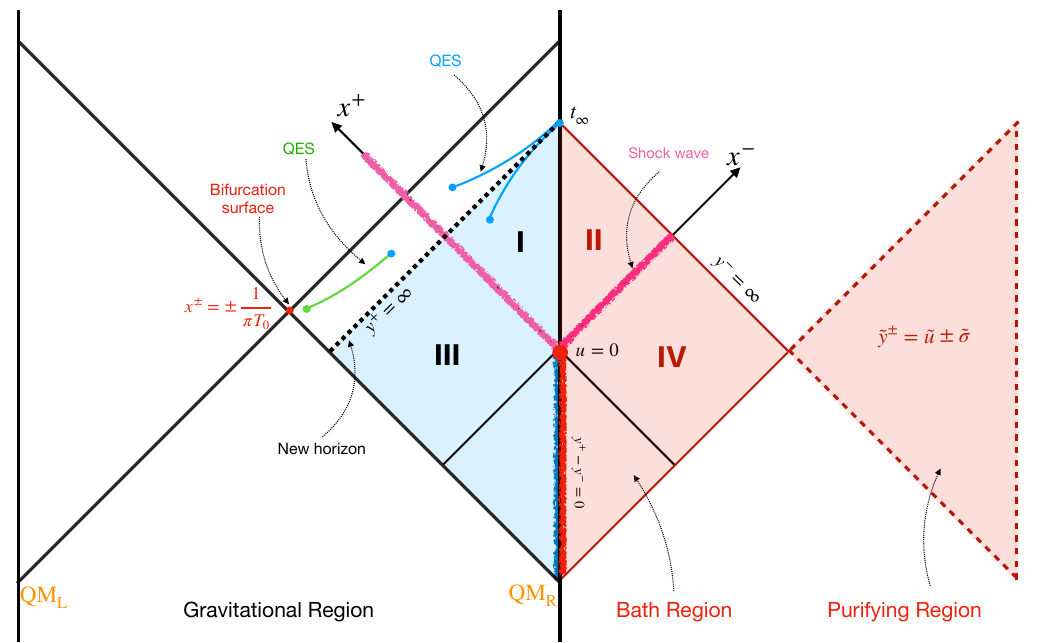
Figure 3 . The Penrose diagram for the AdS 2 black hole coupled with a thermal bath and its purification in flat spacetime at time u = 0 . The (thick) pink lines are the shock waves propagating into the gravitating and bath regions, which are generated by this joining quench. The bifurcation surface of the initial equilibrium black hole is indicated by the red dot. The new horizon is indicated by the black dashed line, i.e. y + = ∞ . Note that only the blue and red shaded regions are covered by the y ± , ˜ y ± coordinates, respectively. The evolution of quantum extremal surface in three phases is presented by the corresponding colored curves, as indicated in figure